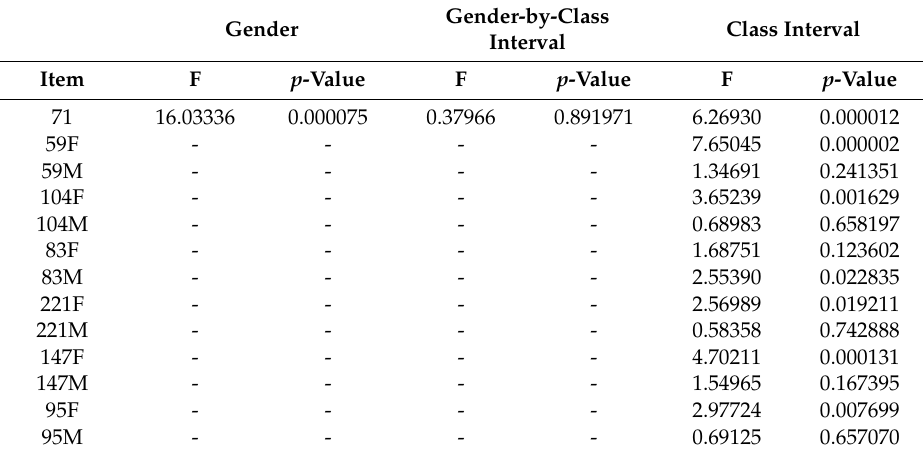
Table 3. Results ( α = 0.05; with Bonferroni correction: α = 0.000081) after resolving items 59, 104, 83, 221, 147 and